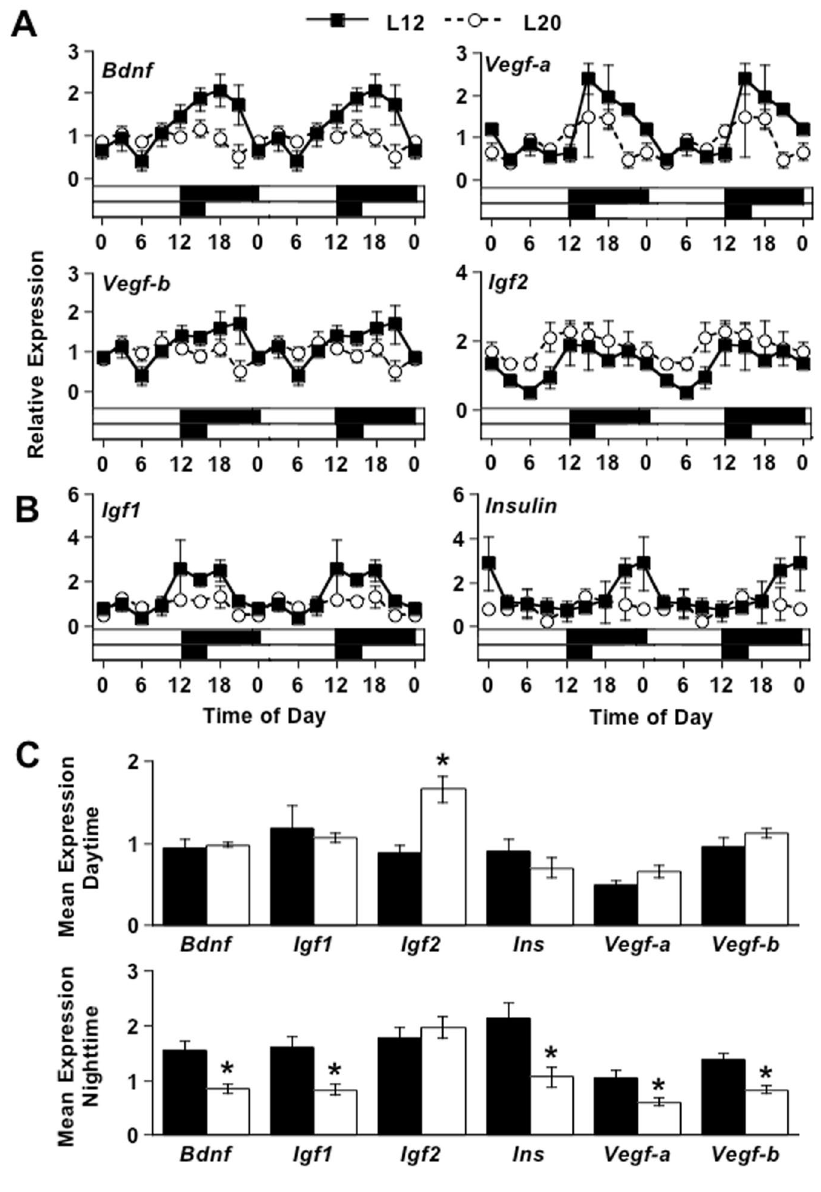
Figure 4. Long days influence hippocampal expression of growth factors in a transcript-specific manner. ( A ) L20 decreased Bdnf , Vegf-a , and Vegf-b , but increased daytime levels of Igf2 . ( B ) L20 did not elevate Igf1 or Insulin . ( A , B ) Note that daily changes in gene expression are double-plotted to facilitate rhythm analysis. Statistical evaluation of transcript rhythms and group differences are described in Table S1. ( C ) Summary of results illustrating that L20 suppressed transcription for most growth factors during the night, but L20 increased Igf2 expression specifically during the daytime. * Student’s t-test, p <